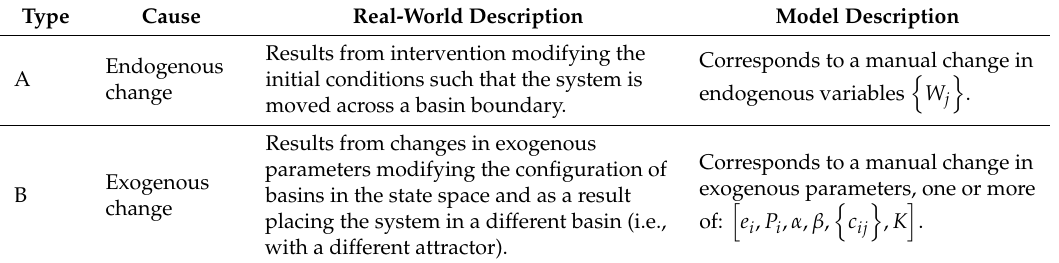
Table 1. Categorization of phase transition causes using the features of state space. Type Real-World Description Model